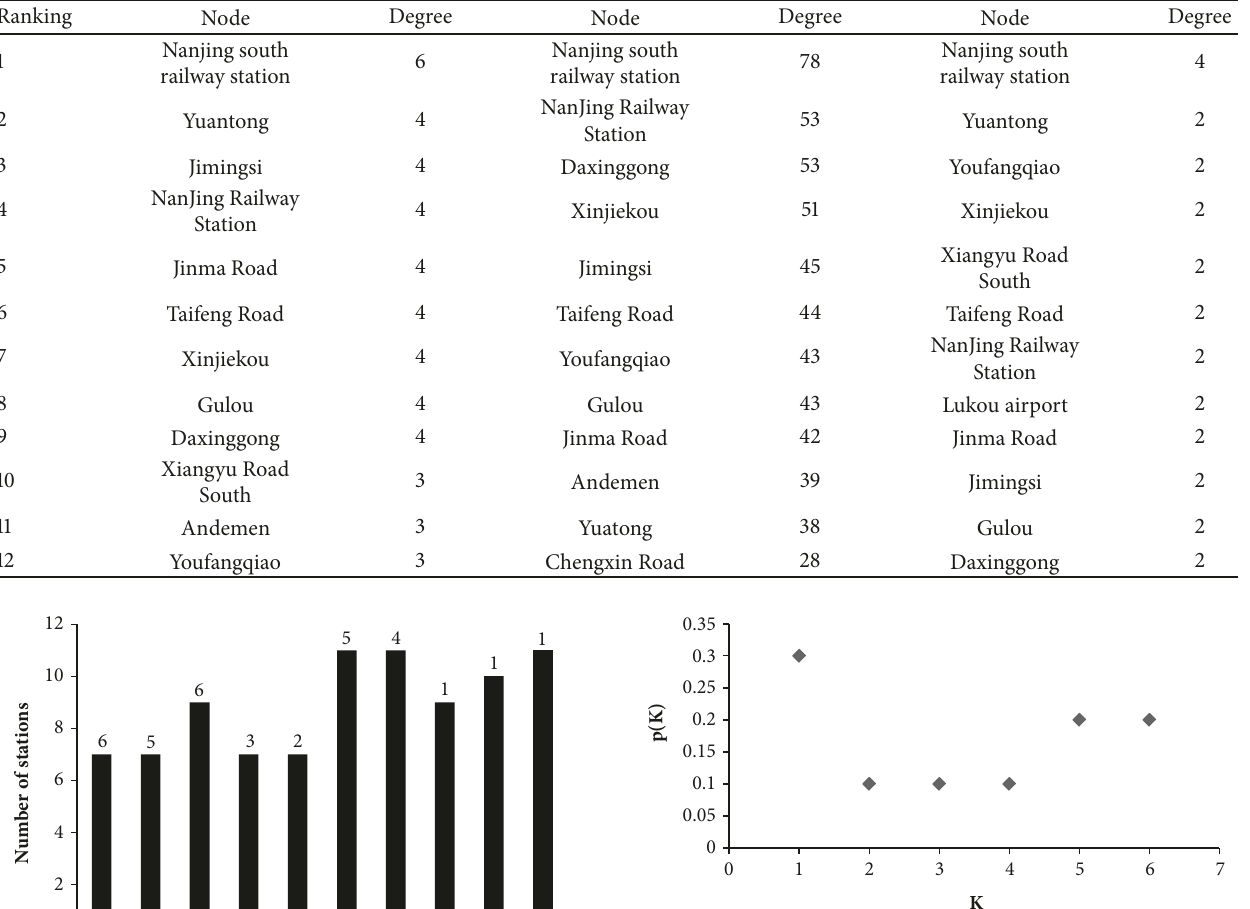
Figure 10: Probability distribution of hypernetwork hyperedge degree in Nanjing